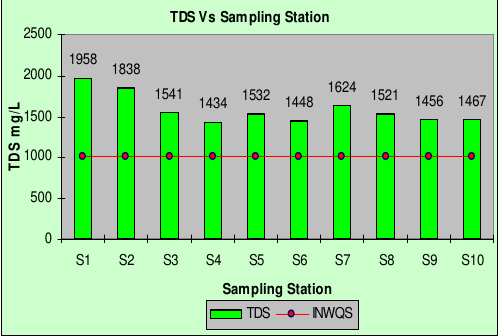
Figure 5. Total Dissolved Solids vs. Sampling Station.